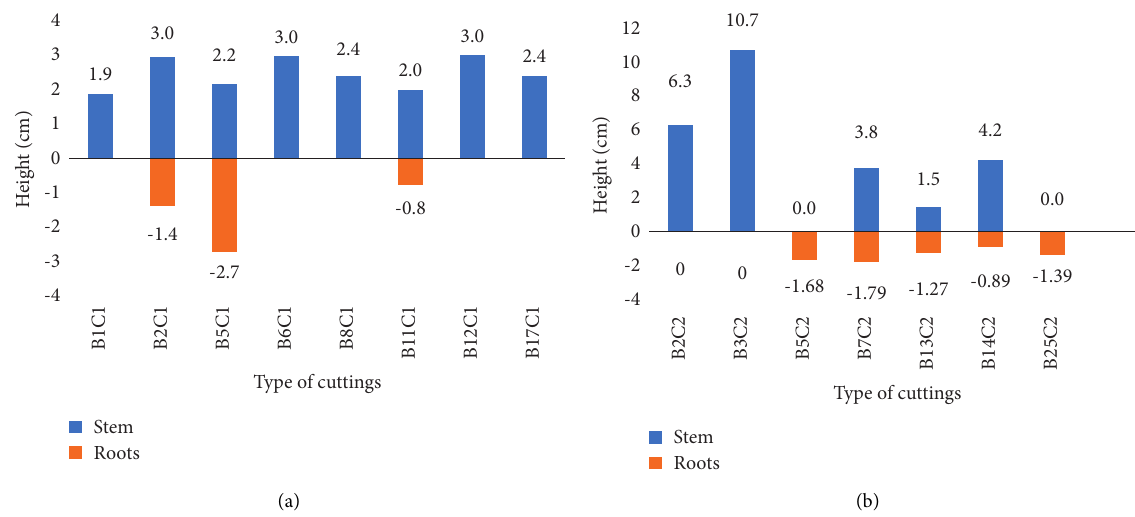
Figure 7: Distribution of roots within class cuttings of Balanites aegyptiaca at the Regional Centre for Agricultural Research (CERRA), Maradi, Niger. Small diameter (a) and large diameter (b). The symbol BiCi means the tree i and the root class i. During the experiment, both the cuttings were numbered. In the end, alone the cuttings making the root were presented in the